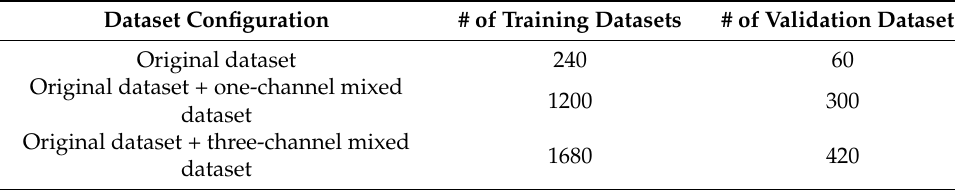
Table 3. Number of datasets after the augmentation, NEU-DET dataset.